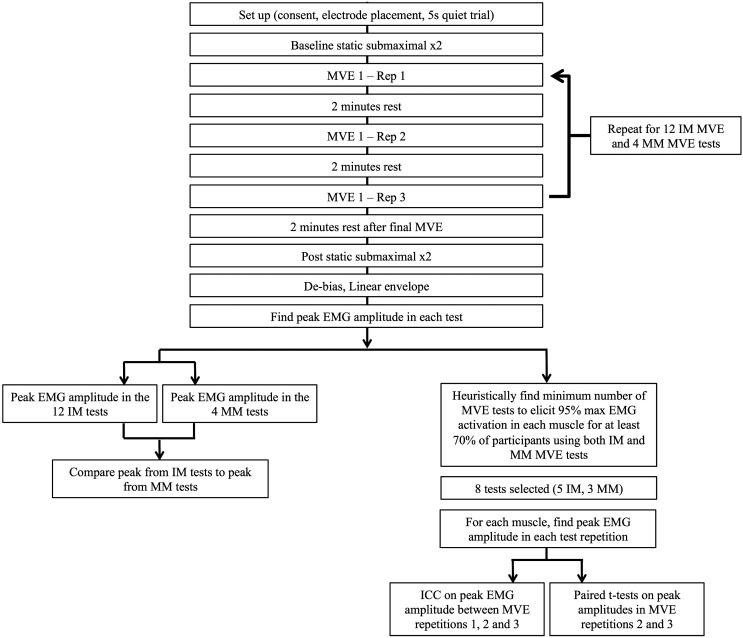
Overview of study protocol and analyses. IM = individual muscle test, MM = multi-muscle test.